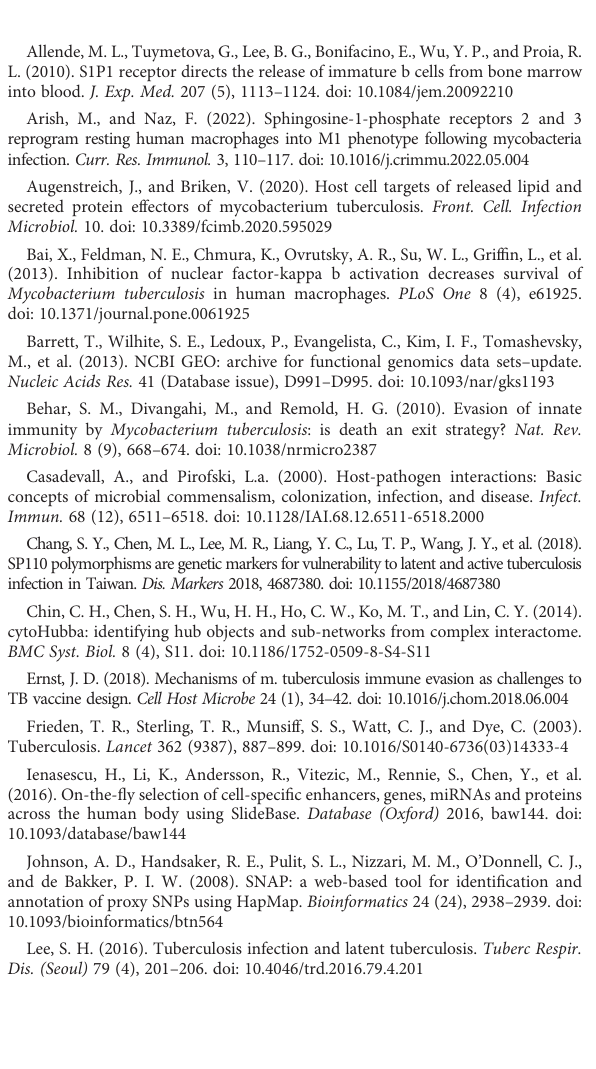
SUPPLEMENTARY TABLE 1 List of 2038 DEGs identi fi ed by